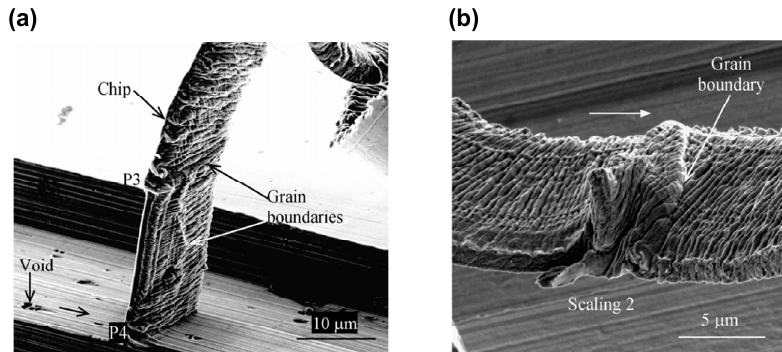
Figure 10. Grain boundary e ff ect on the morphology of cutting chips for di ff erent kinds of work material: ( a ) raised line structure on the cutting chip of aluminium alloy Al6061; ( b ) step structure on the cutting chip of polycrystalline copper. Reproduced with permission from [113,114].